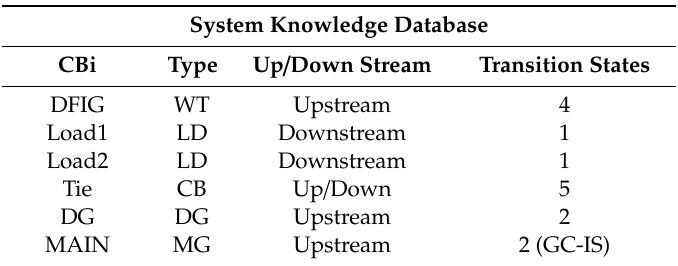
Table 1. System knowledge representing subjective elements for decision